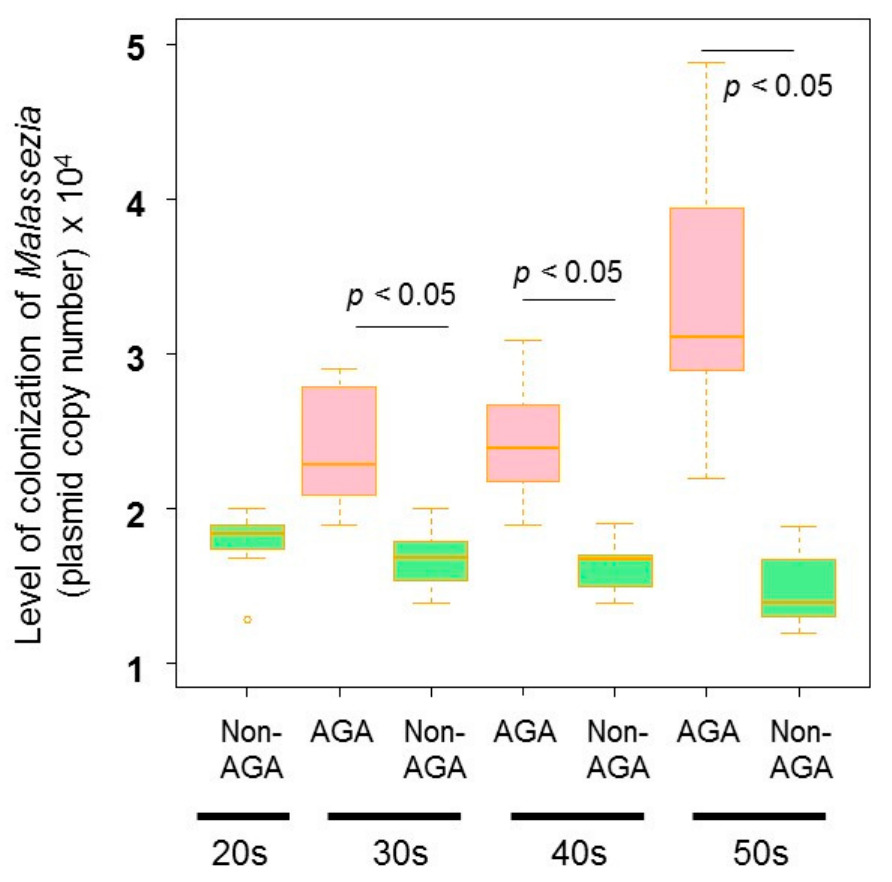
Figure 3. qPCR analysis of Malassezia colonization. There was a greater degree of Malassezia colonization in the AGA group than in the non-AGA group at all ages. The total Malassezia species colonization levels were determined via real-time PCR using a TaqMan probe.